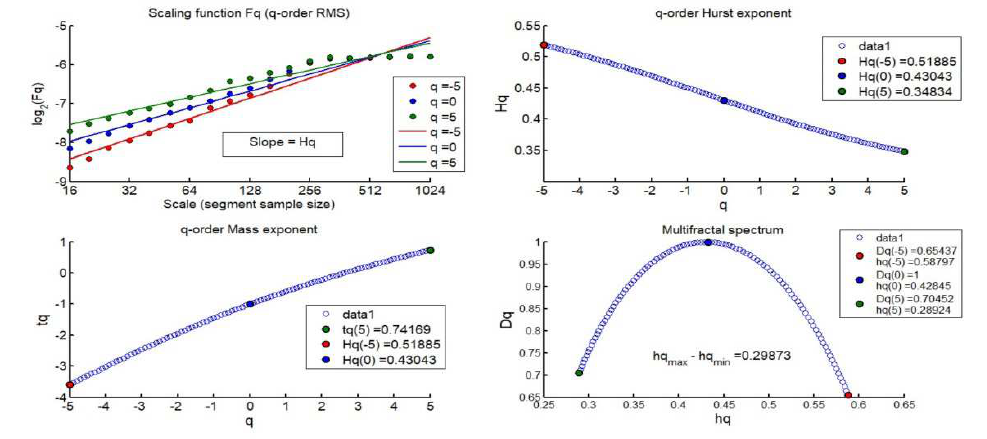
Figure A7. Hurst exponent value Hq (5) in 2017